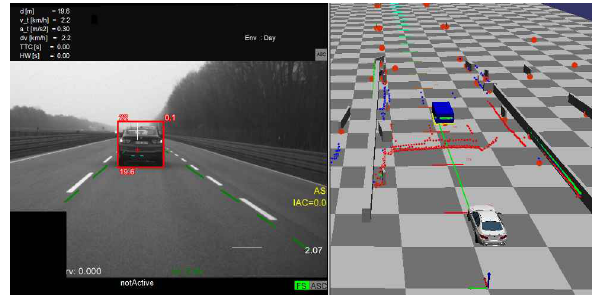
Figure 4: Camera capture (left) of a scene and visualization of scanner data (right). Ego vehicle is drawn as gray model, the classified (car, blue) target ahead. Current scan points are drawn as red, blue and green pixel. Objects reference points are red spheres. The green vector between ego and target is the reference (GPS-RTK) resultant.